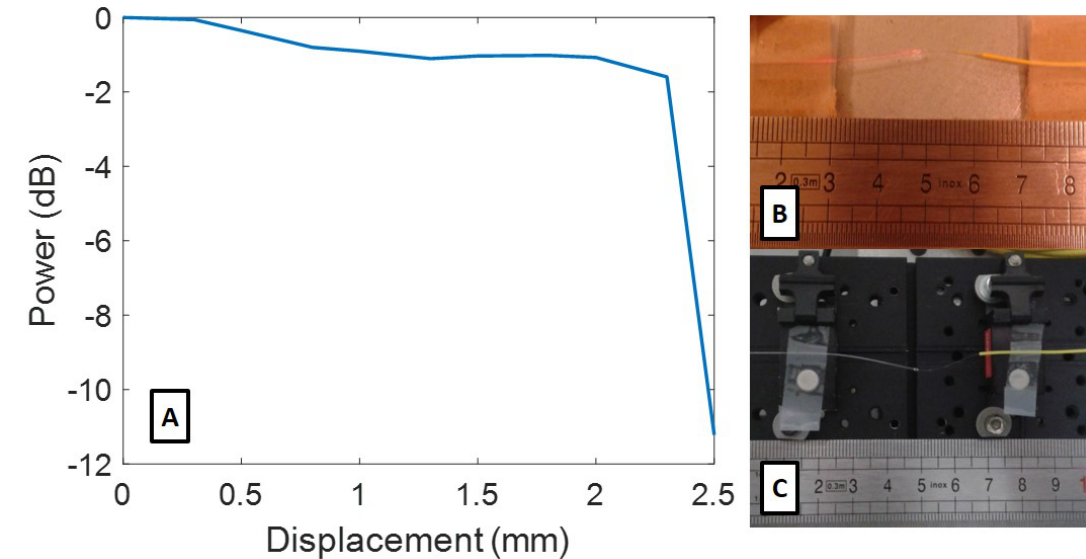
Figure 6. Amplitude changes for the deformation on a connection joint in the CYTOP fibre ( A ); state of a coupling joint after 120 kGy of radiation ( B ); and state of a pristine coupling joint under mechanical deformation ( C